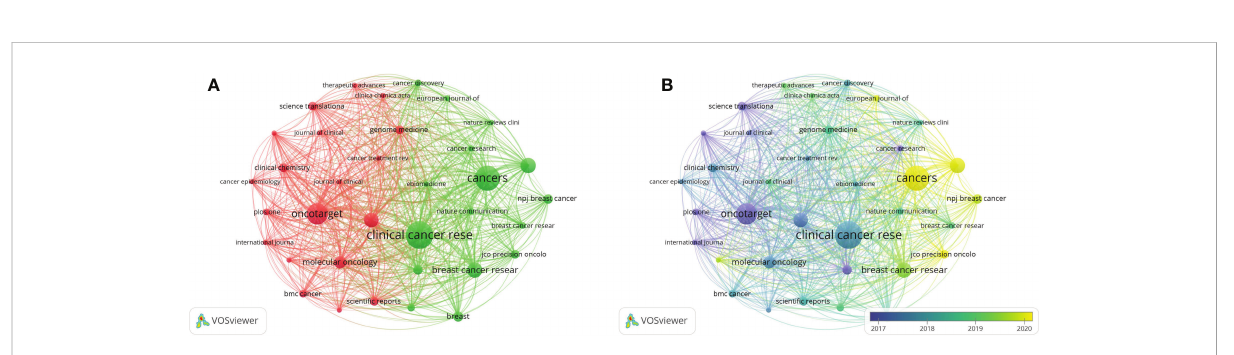
FIGURE 5 Bibliographic coupling analysis of sources in this fi elds. (A) Bibliographic coupling analysis of journals in network visualization map. (B) Bibliographic coupling analysis of journals in overlay visualization map.